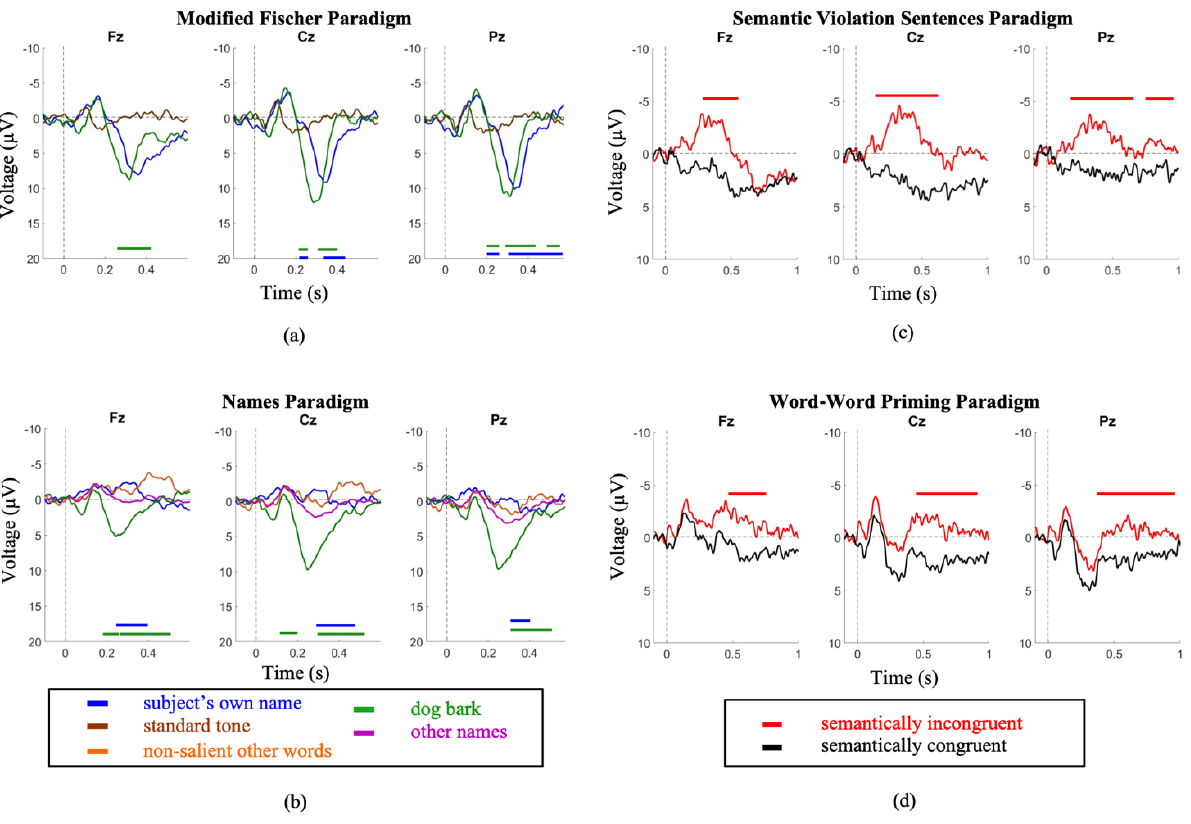
Figure 2. Elderly group grand average waveforms. Intervals of significance indicate where the waveform is significant in relation to ( a ) the standard tone stimulus (MF Paradigm), ( b ) the other names stimulus (SON Paradigm), ( c ) the semantically congruent stimulus (SVS paradigm), and ( d ) the semantically congruent stimulus (WWP paradigm). Time periods where significant differences occurred are indicated by color-matched bars.